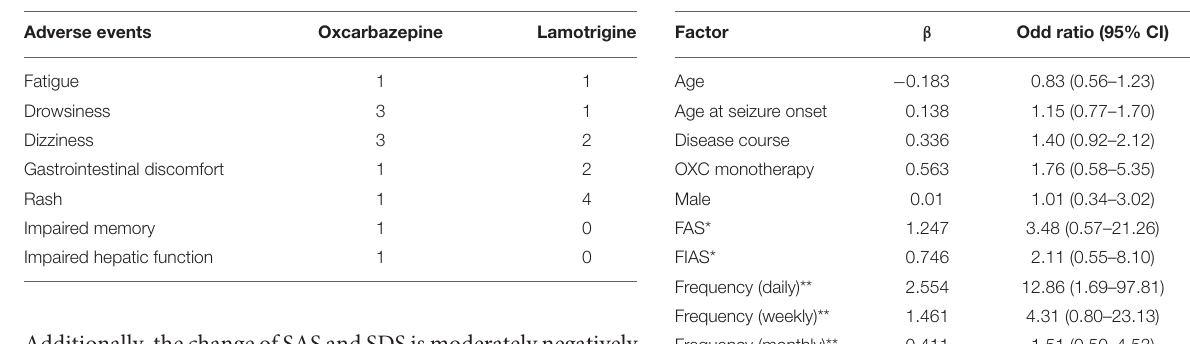
TABLE 2 | Treatment-related adverse events. TABLE 3 | Multiple logistic regression analysis for seizure free